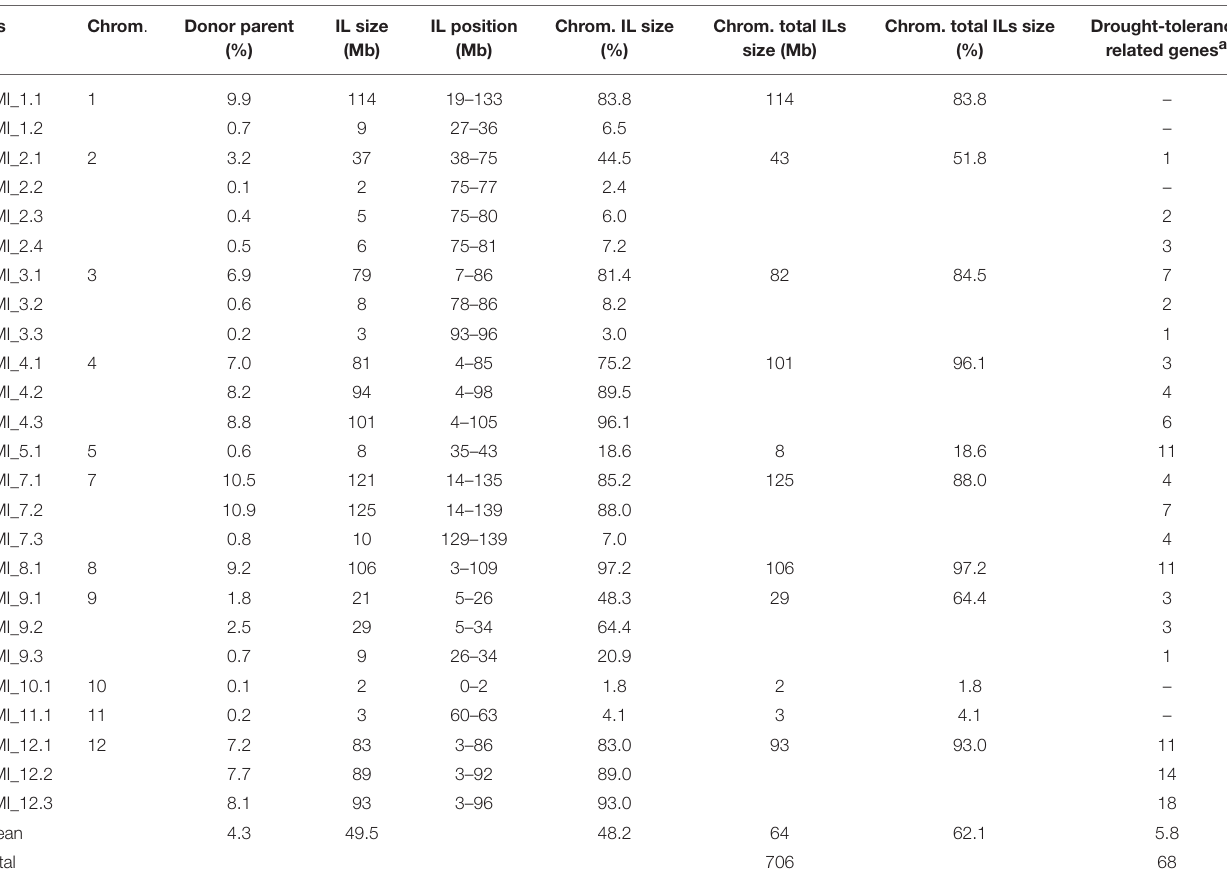
TABLE 2 | Statistics of the S. incanum MM577 introgression lines (ILs) in the genetic background of S. melongena AN-S-26 using a 12 pseudomolecule eggplant genome (Italian Eggplant Genome Sequencing Consortium; Barchi et al., 2016), and a number of candidate genes for drought tolerance. ILs Chrom